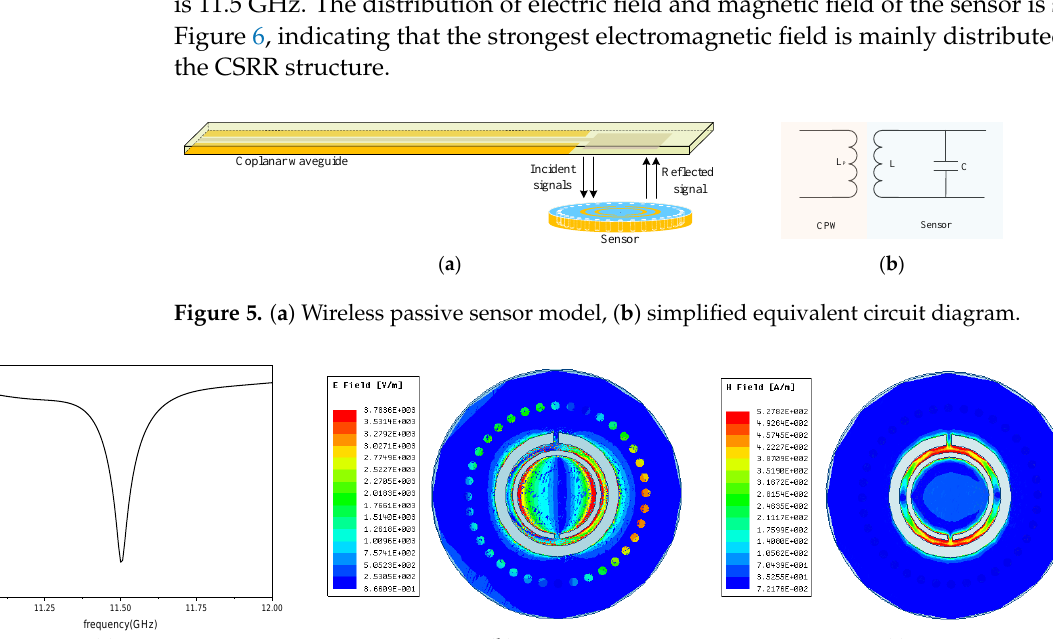
( c ) Figure 7. ( a ) Sensor manufacturing process, ( b ) sensor sintering curve, ( c ) high temperature sensor and inquiry antenna. 0 100 200 300 400 500 600 700020040060080010001 20 0 1 40 0 T e m pe r a t u r e /  C